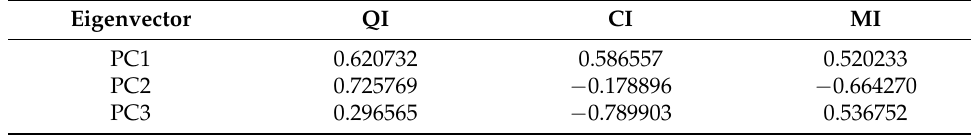
Table 2. Eigenvector matrix of the sericite obtained via the PCA method. Eigenvector